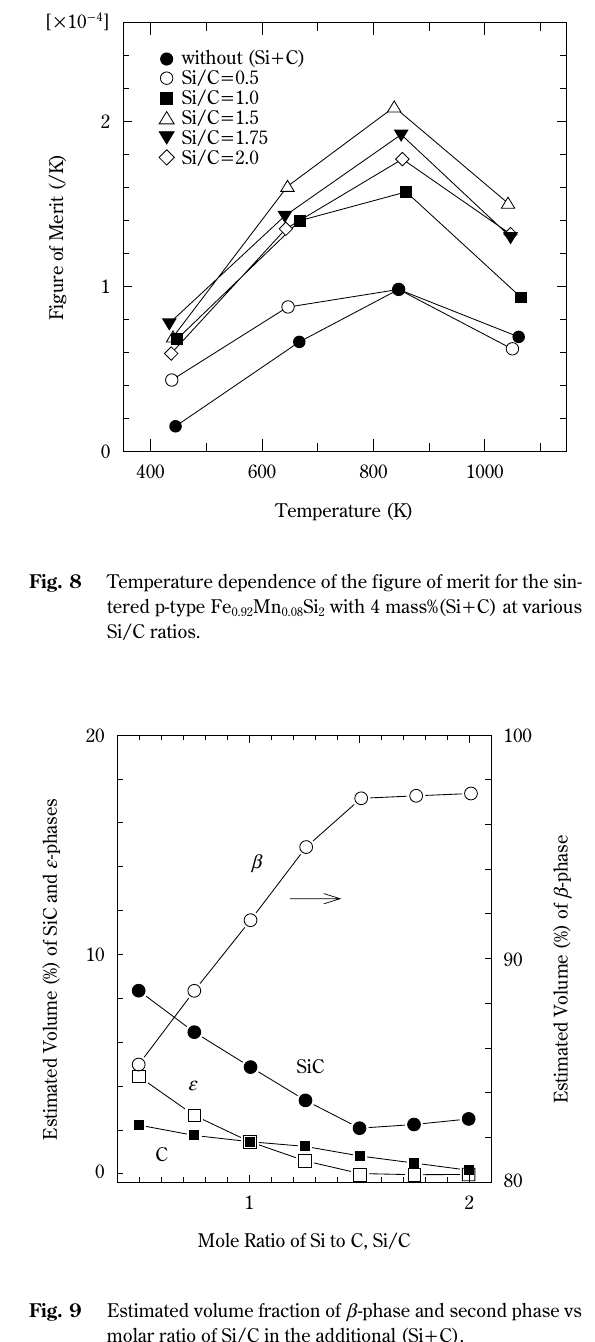
Fig. 9 Estimated volume fraction of b -phase and second phase vs molar ratio of Si/C in the additional (Si (cid:4)